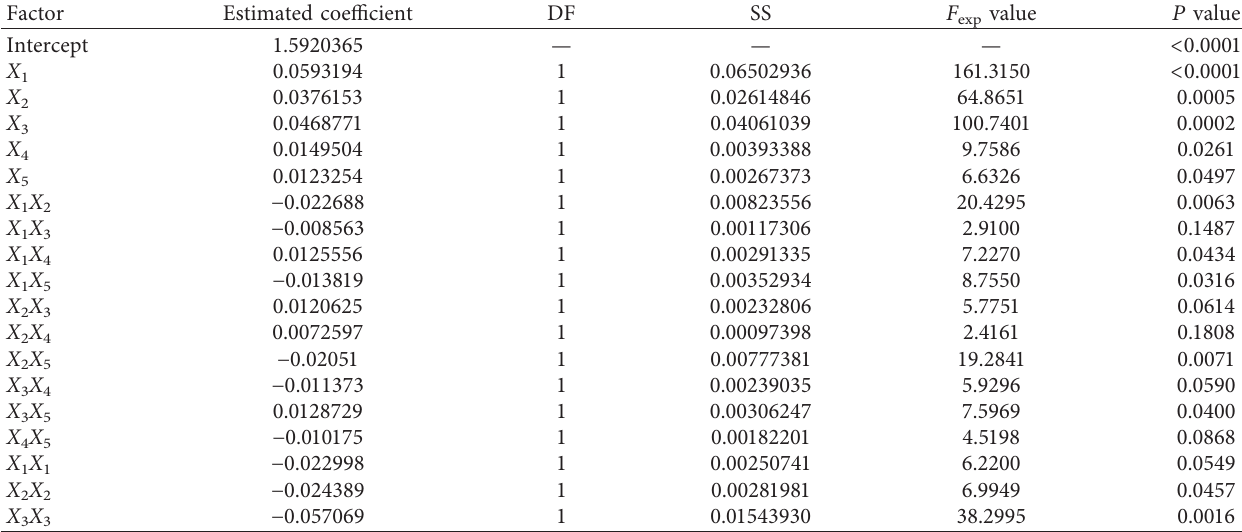
Table 4: Model coefficient estimated by multiple linear of Ca/P ratio response.